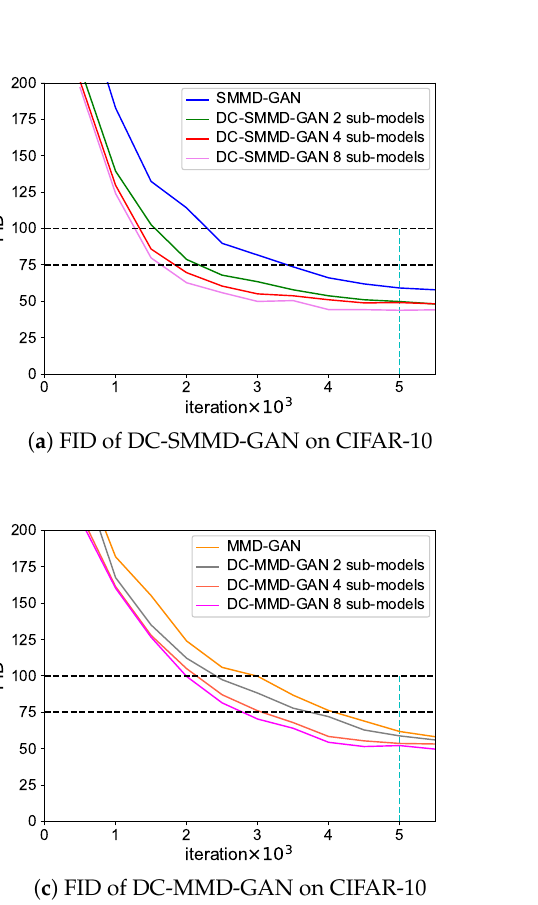
Figure 7. The evolution of FID and KID as the number of iterations increases when trained on CIFAR-10. Compared to the original models, the proposed methods can make the training more